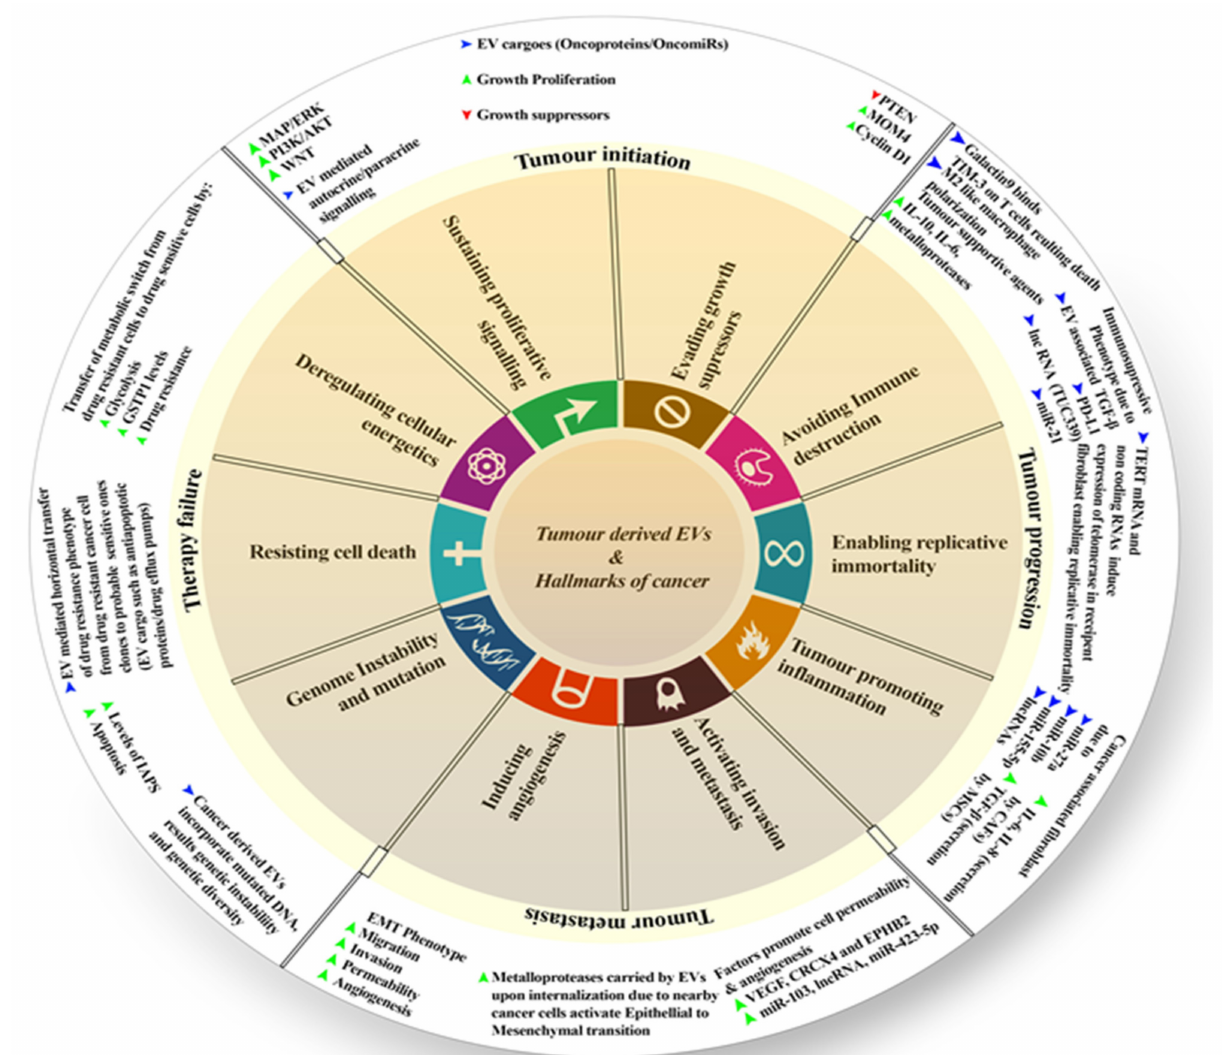
Figure 1. Diagrammatic representation of EVs’ role in influencing different hallmarks of